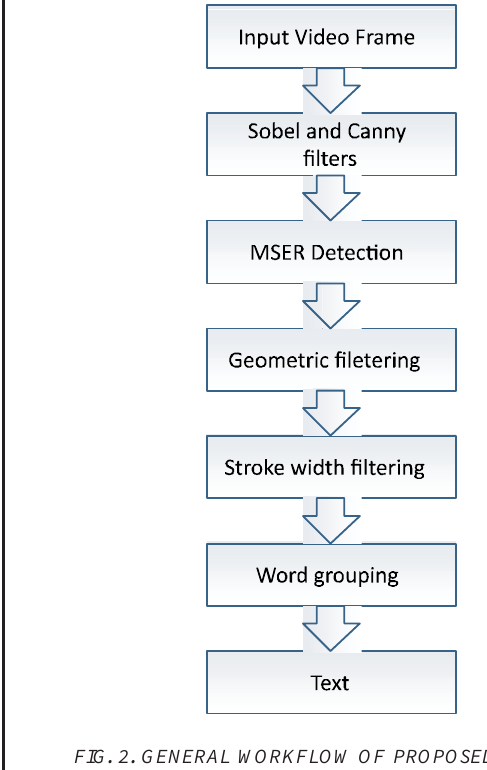
FIG. 2. GENERAL WORKFLOW OF PROPOSED